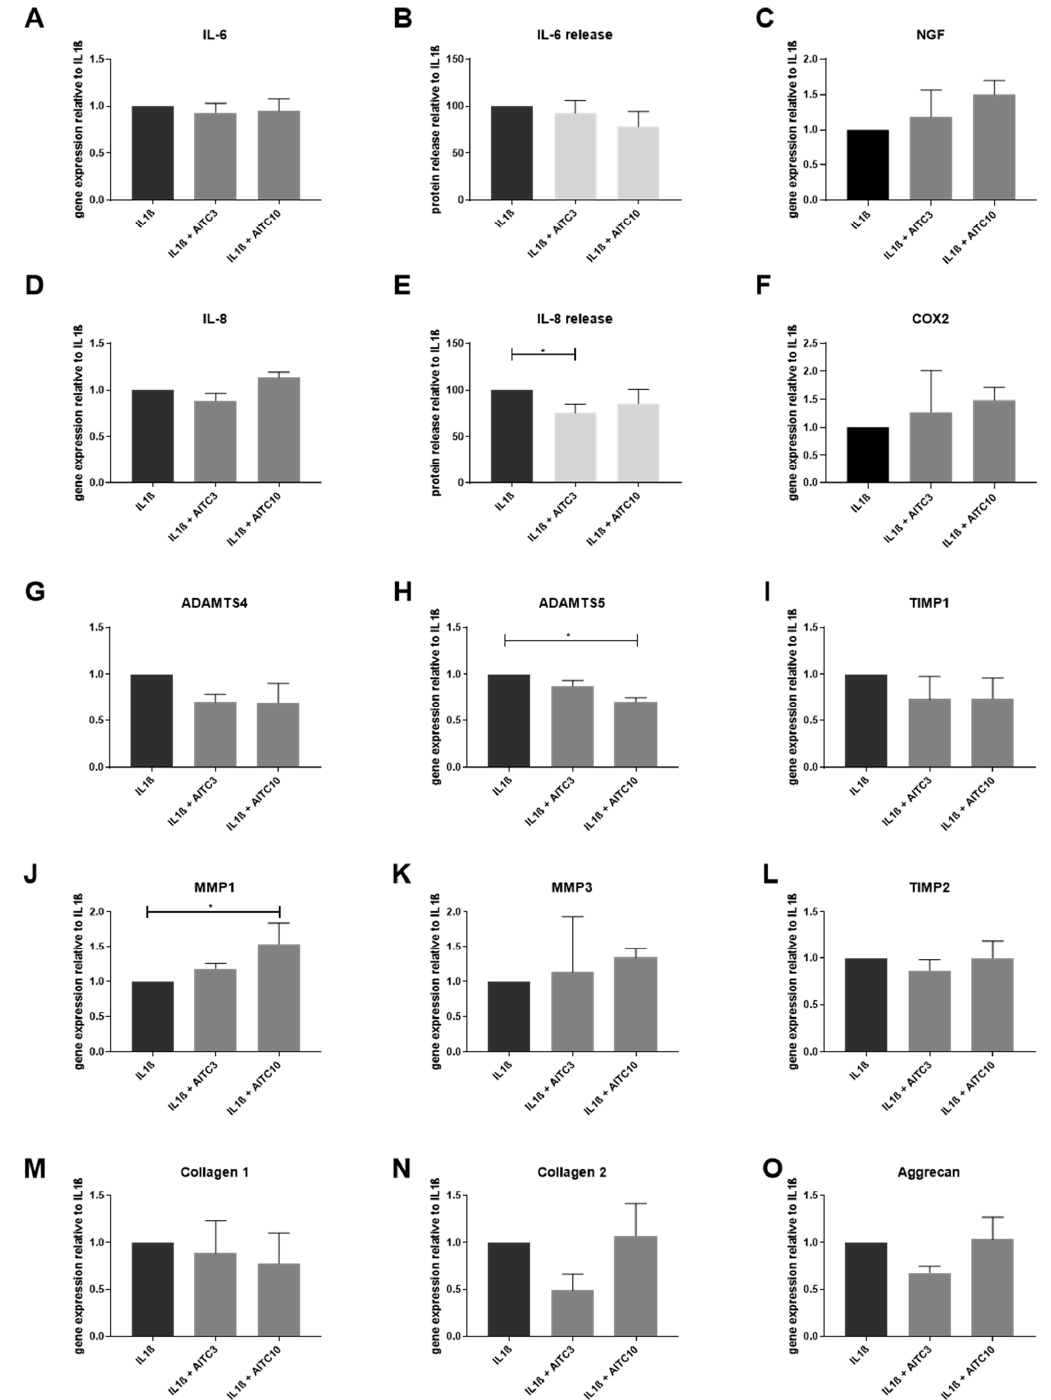
Figure 5. The effects of TRPA1 agonist allyl isothiocyanate (AITC) on the expression of inflammation markers and ECM molecules in IL-1 β -treated cells. Gene expression of ( A ) IL-6 and ( D ) IL-8 in IVD cells treated with 10 ng/mL IL-1 β ± 3 and 10 µ M AITC. Protein release of ( B ) IL-6 and ( E ) IL-8 in IVD cells that were treated with 10 ng/mL IL-1 β ± 3 and 10 µ M AITC. Gene expression of ( C ) NGF, ( F ) COX-2, ( G ) ADAMTS4, ( H ) ADAMTS5, ( J ) MMP1, ( K ) MMP3, ( I ) TIMP1 and ( L ) TIMP2, ( M ) COL1A1, ( N ) COL2A1, and ( O ) Aggrecan in IVD cells that were treated with 10 ng/mL IL-1 β ± 3 or 10 µ M AITC. Graphs show gene expression and protein release calculated relative to IL-1 β treatment (mean ± SD, n = 3–4). Asterisks indicate statistical significance (* p < 0.05, Kruskal–Wallis test and Dunn’s multiple comparison